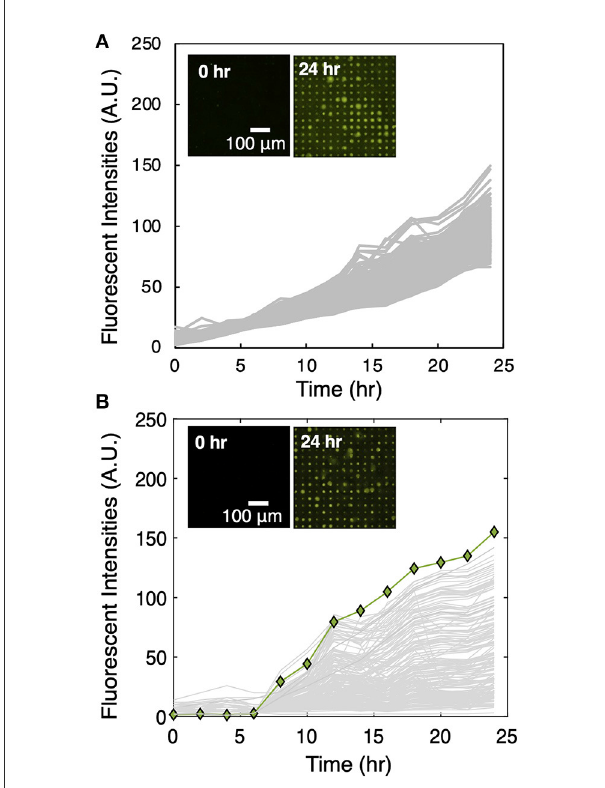
FIGURE2 (A) Sp7 growth trajectories across a 225 microwell subset in the MRA device during monoculture. (Inset) Corresponding TLFM images of a sample 15 × 15 array of microwells during Sp7 monoculture. (B) Sp7 growth trajectories of a sample 15 × 15 array containing a Sp7 promoter well during Sp7 co-culture with microbes recovered from maize rhizosphere. Growth trajectories that result in the highest end-point fluorescent signal (green line) indicate a well where highest levels of Sp7 growth promotion occurred. (Inset) Corresponding TLFM images of the sample 15 × 15 array of microwells during Sp7